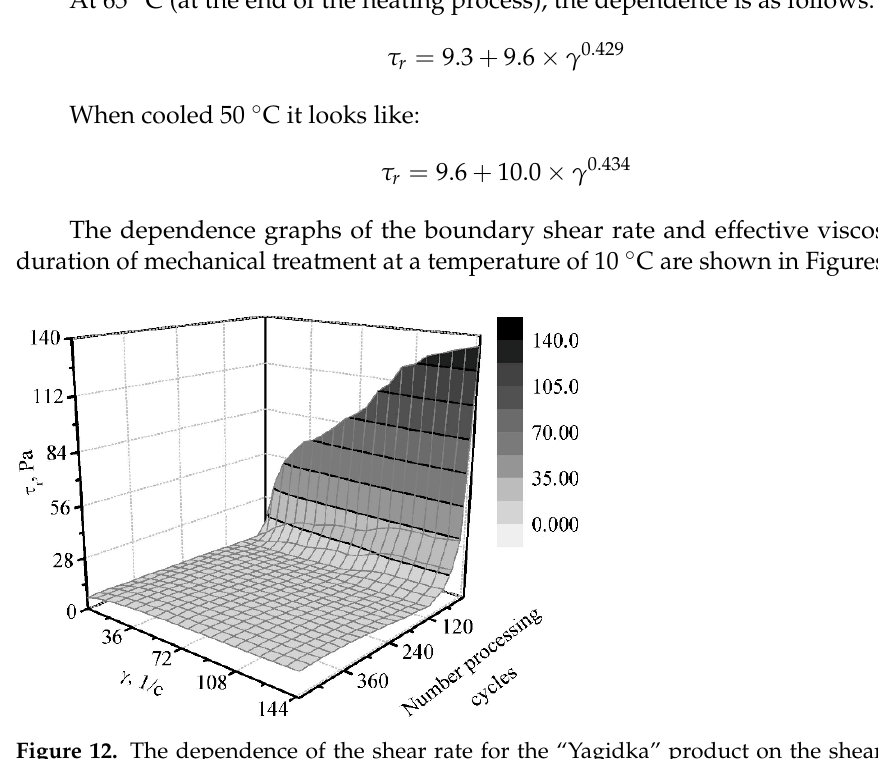
Figure 12. The dependence of the shear rate for the “Yagidka” product on the shear rate in the emulsifier at a temperature of 10 °C.